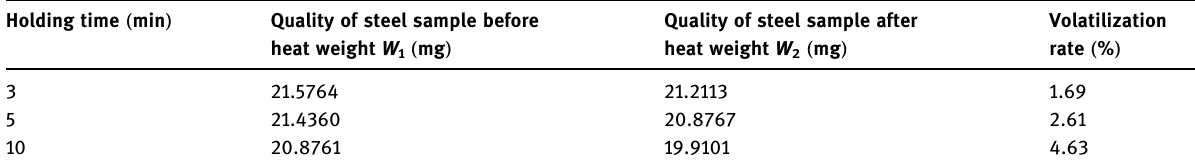
Table 3: Variation of sample quality under di ff erent heat preservation times Holding time ( min ) Quality of steel sample before